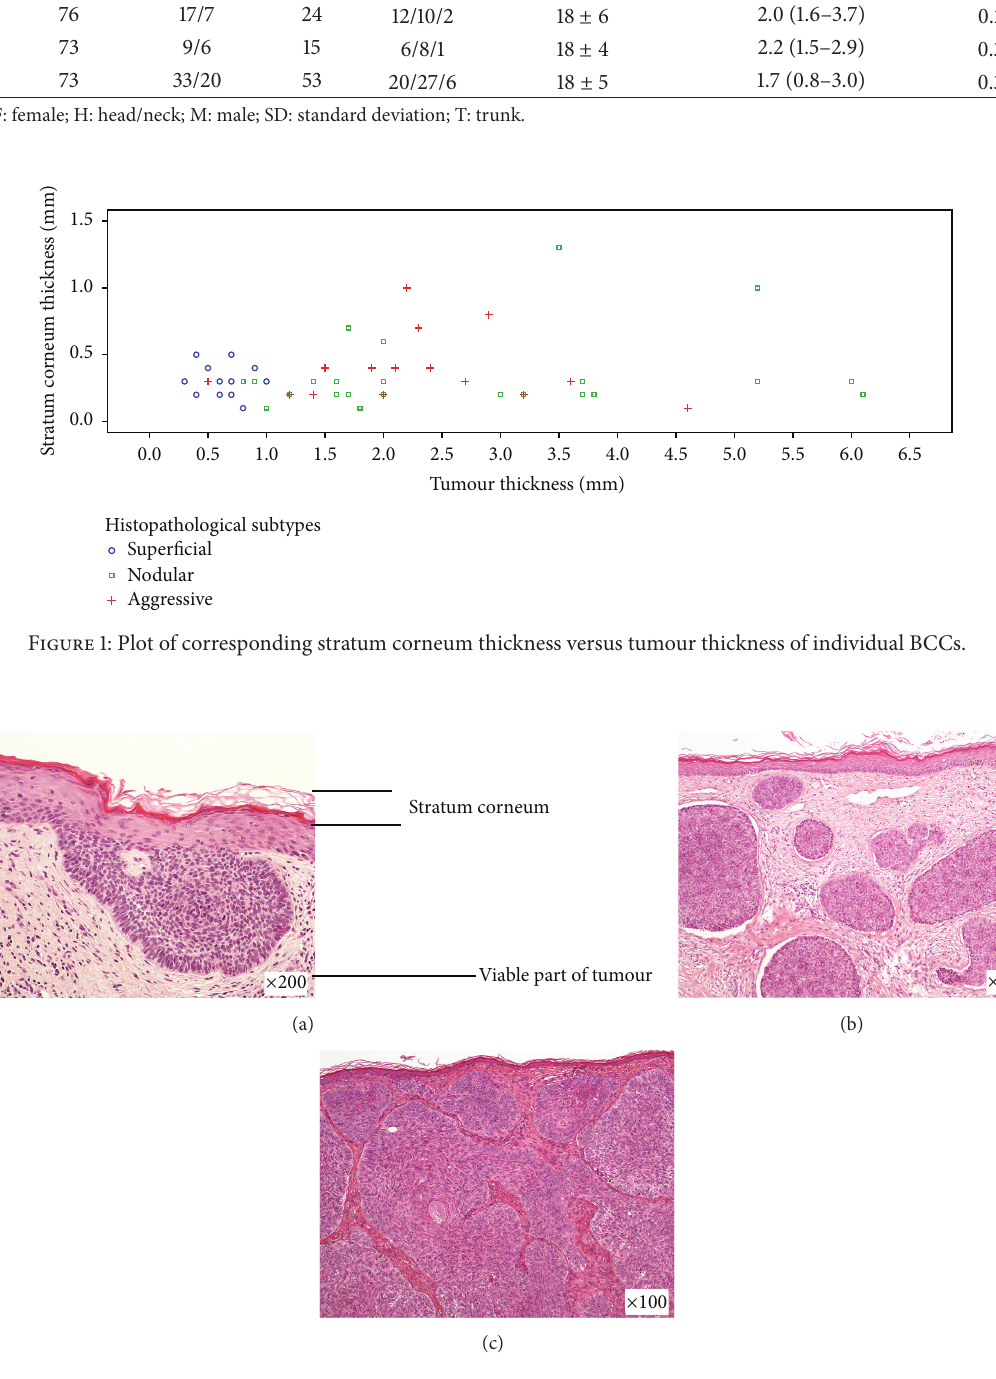
Figure 2: HES-stained histopathological images of sections of the stratum corneum and the viable parts of tumour cells from three basal cell carcinomas with different growth patterns: (a) superficial tumour from the back, (b) nodular tumour from the chest, and (c) aggressive tumour from the